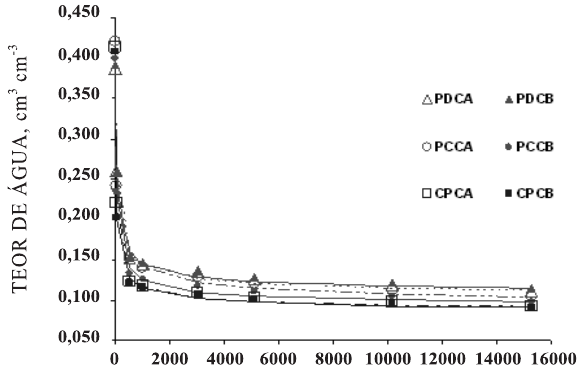
Figura 2. Curvas de retenção de água de um Latossolo Vermelho-Amarelo distrófico sob plantio direto (PD), pastagem cultivada (PC) e